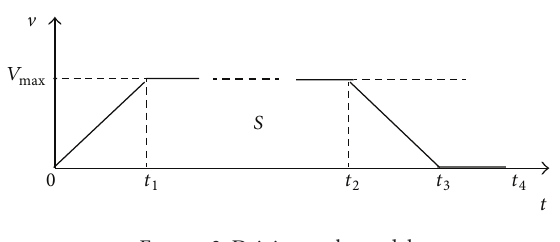
Figure 2: Driving cycle model.